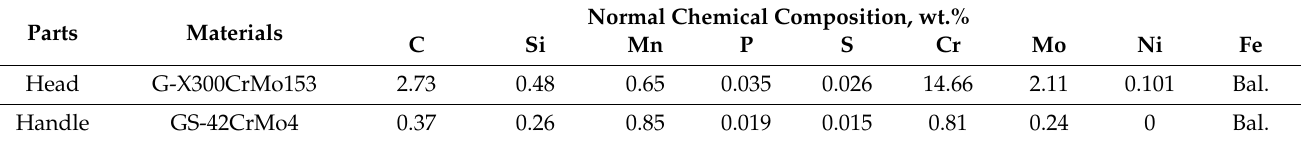
Table 1. Normal compositions of the used LAS and HCCI.